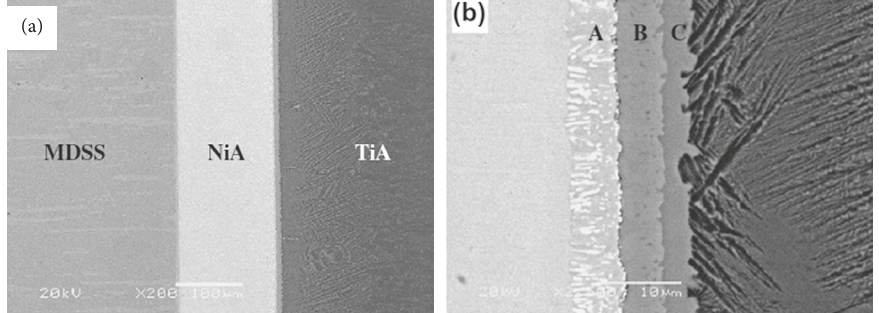
Figure 6: BSE micrographs of diffusion-bonded joints at 900 ° C: (a) whole joint; (b) NiA-TiA side. (A) Ni (reproduced from [79] with